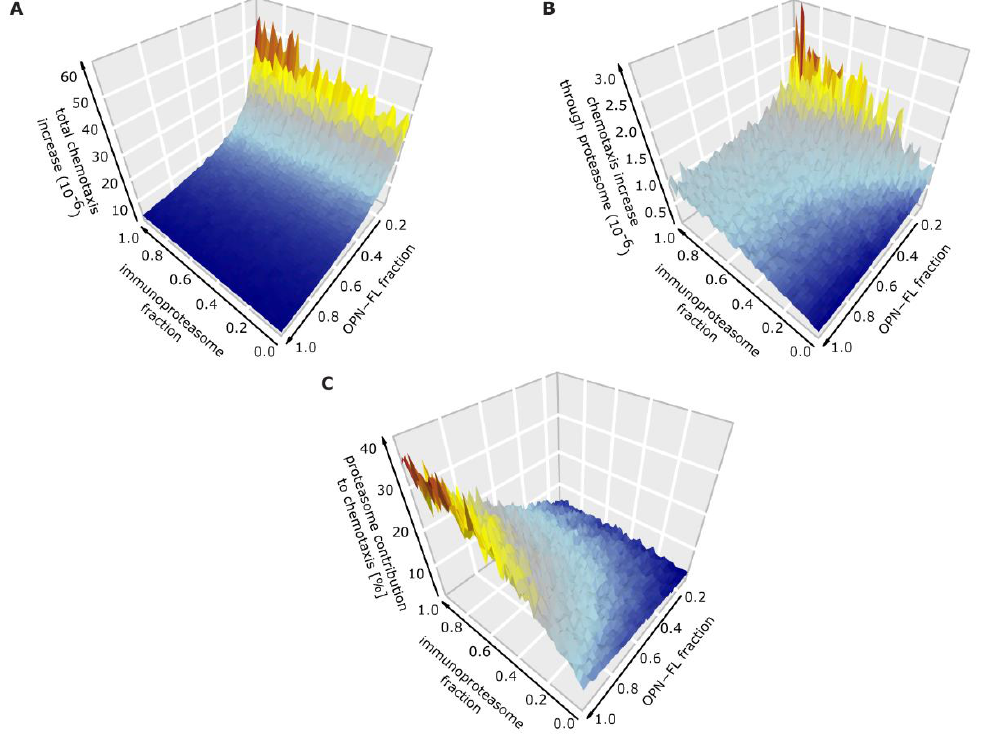
Figure 5. Effect of proteasome isoforms and thrombin on chemotaxis in RRMS patients. ( A ) Overall expected intensification in chemotaxis from RRMS remission to relapse dependant on the ratio of standard- and immuno-proteasomes, as well as on the ratio of OPN-FL compared to OPN-N and OPN-C. ( B ) Expected increase in chemotaxis from RRMS remission to relapse based only on proteasome-generated OPN fragments. ( C ) Relative contribution of proteasome isoforms to the overall expected level of chemotaxis.